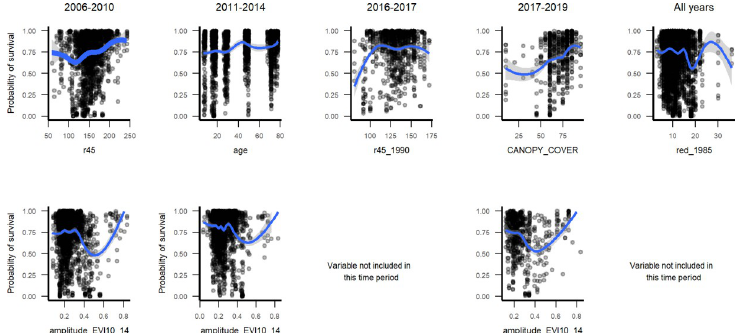
Fig 6. Marginal plots through time for metrics related to canopy development or deciduousness. The top row shows r45 for t2, age for t3, r45_1990 for t4a and tree canopy cover for t4b. The middle row shows the red band from Landsat Multispectral Scanner imagery dated in 1985 (red_1985). The bottom row shows greenness amplitude, derived from images dated from 2011–2014, and tree canopy cover. Tree canopy cover in 2006–2010 is modeled from remote sensing data but was field-determined for the interval ending in 2017–2019.